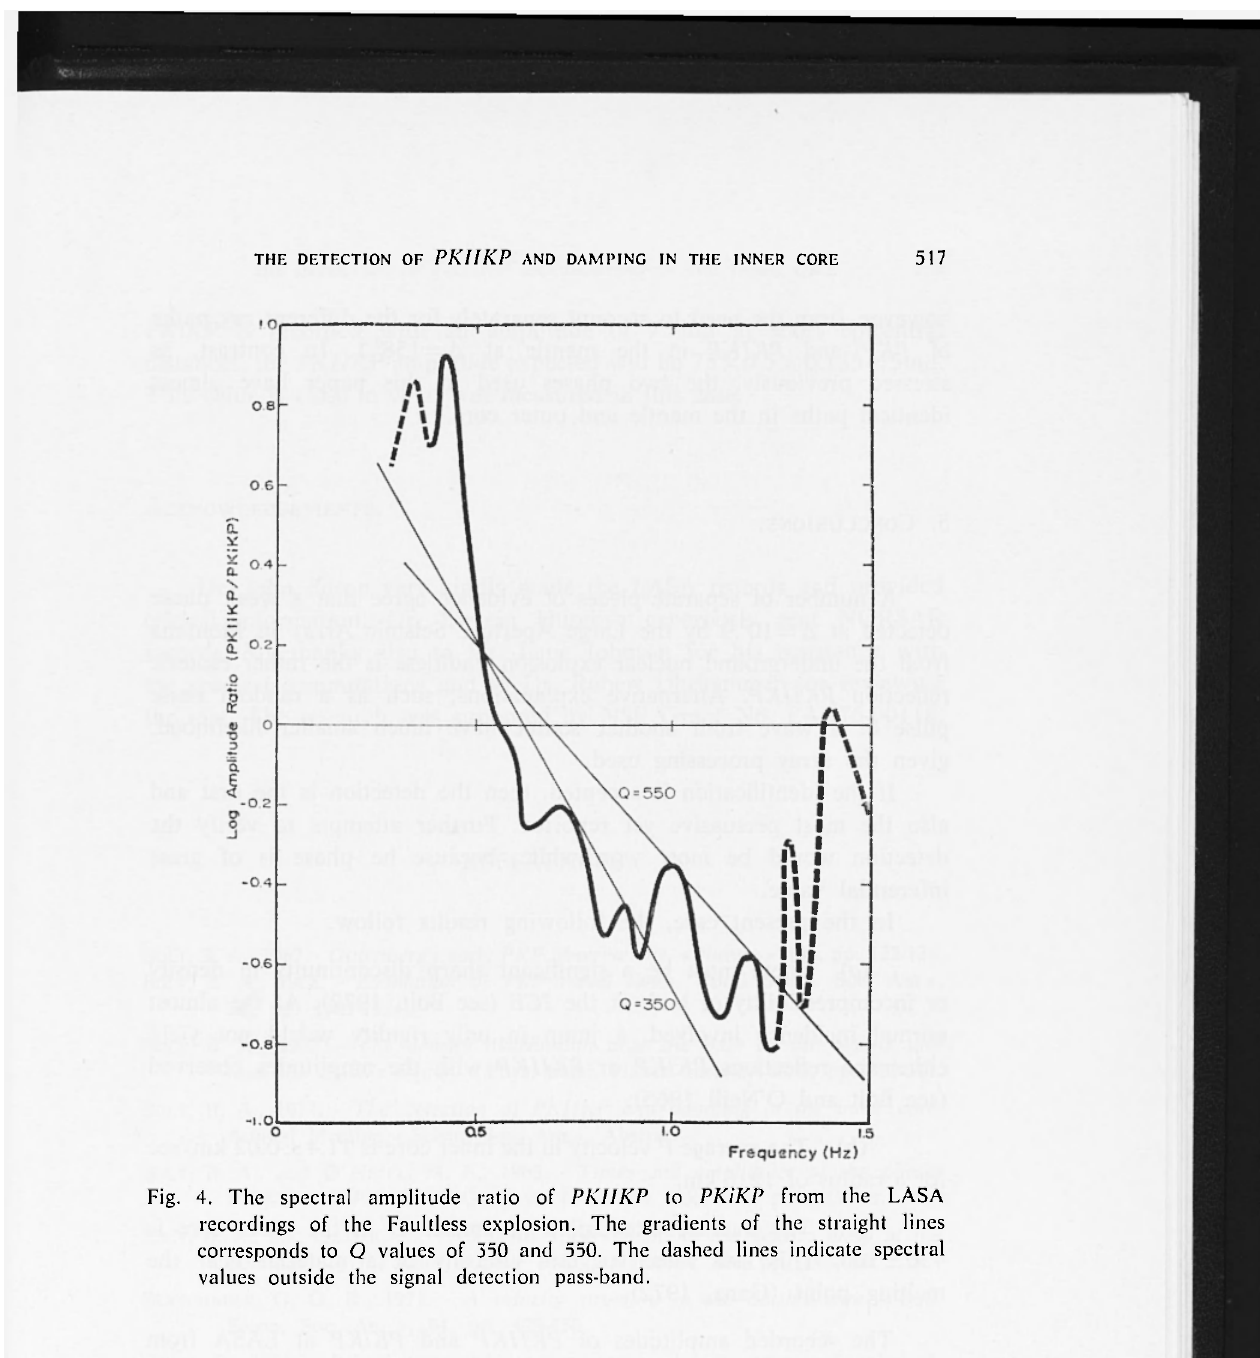
Fig. 4. The spectral amplitude ratio of PKIIKP to PKiKP from the LASA recordings of the Faultless explosion. The gradients of the straight lines corresponds to Q values of 350 and 550. The dashed lines indicate spectral values outside the signal detection